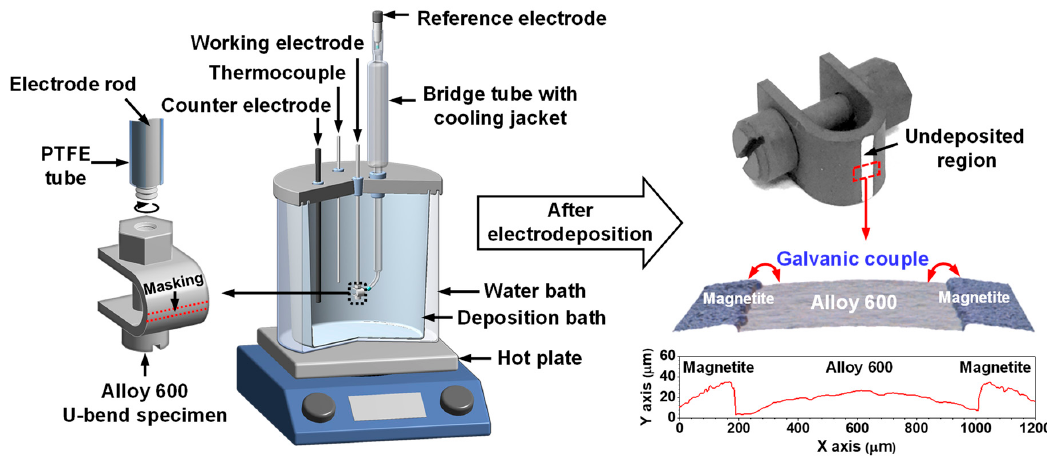
Figure 2. Schematic for the preparation of the magnetite-deposited SCC specimen.